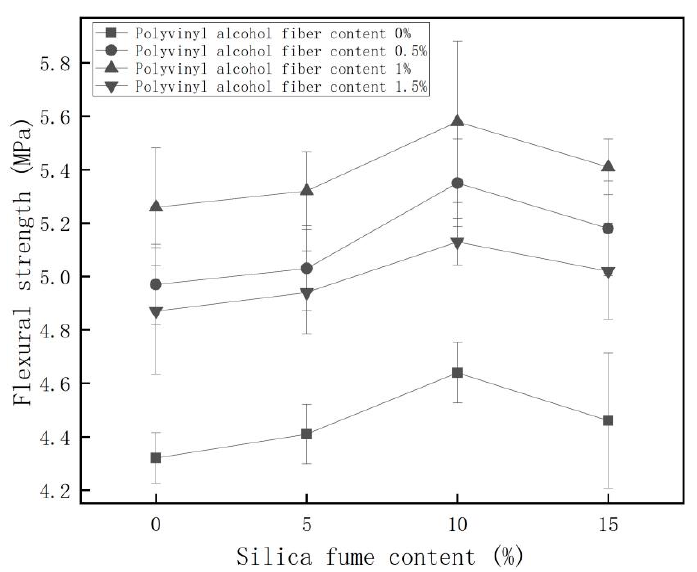
Figure 4. Change in flexural strength.